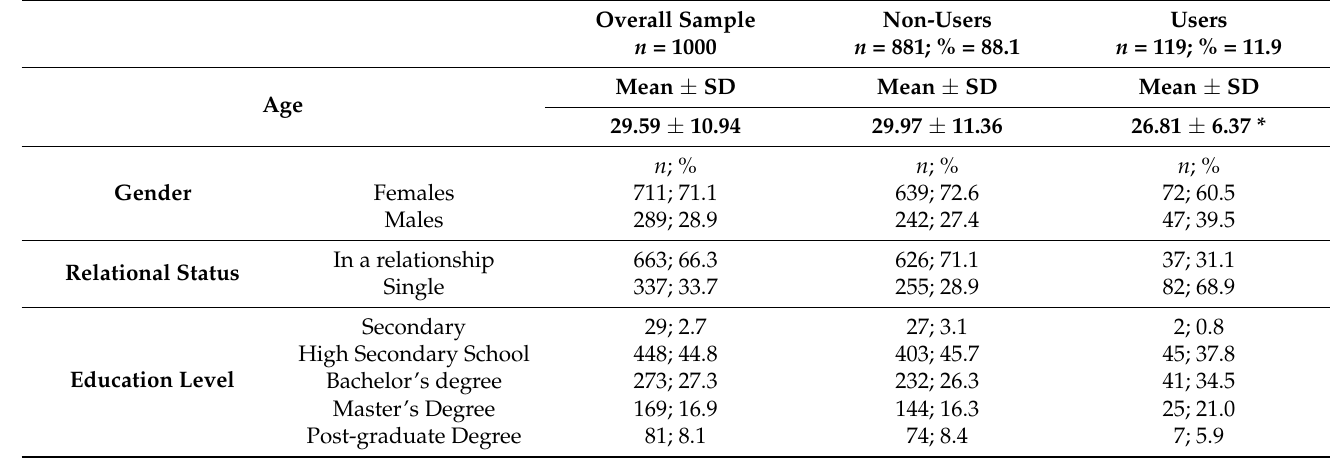
Table 1. Demographics (sample n = 1000). Overall